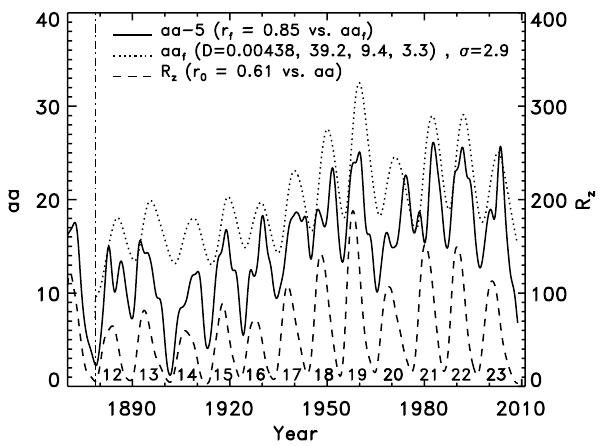
Fig. 1. Monthly mean aa − 5 (solid) and R z (dashed) smoothed with a 24-month Gaussian filter. The dotted line shows the recon- structed aa series ( aa f ) from August 1878 through August 2008 (Cycles 12–23) by Model (7). The correlation coefficients of aa with R z and aa f are r 0 = 0 . 61 and r f = 0 . 85,